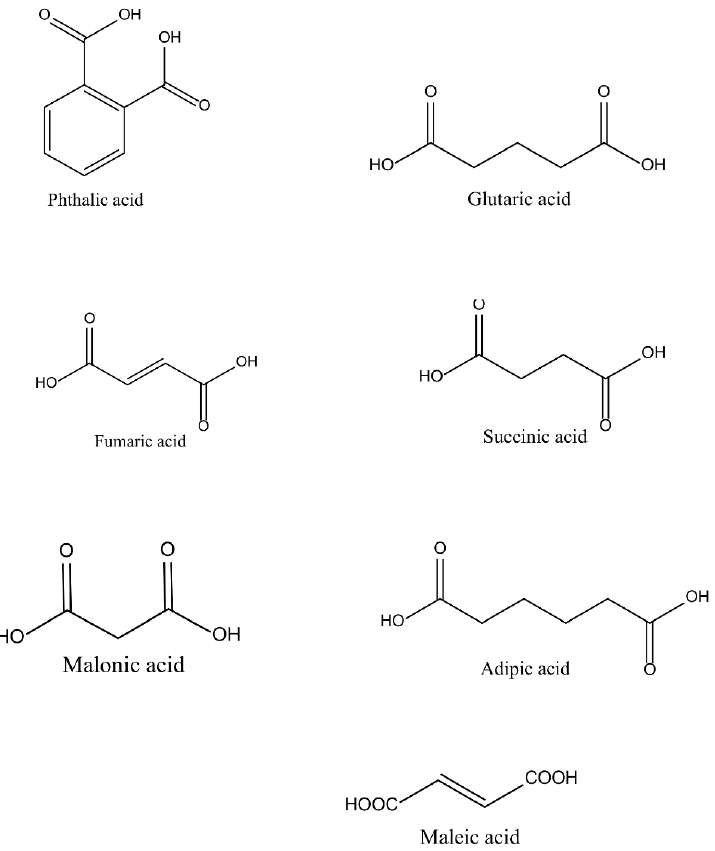
Figure 6. Some common chemical structures of acids that are used for the synthesis of UPs [59].